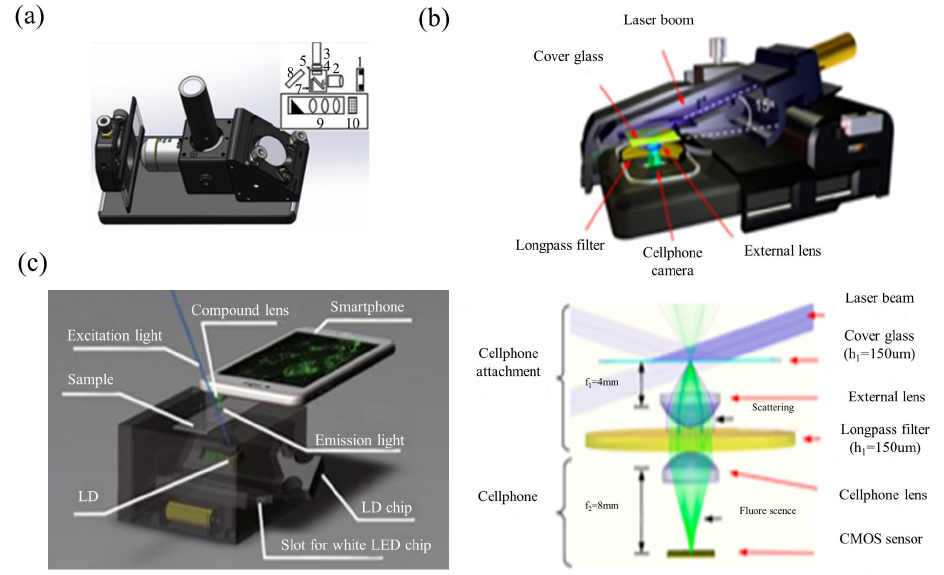
Figure 11. Smartphone-based fluorescent microscopy setups. ( a ) schematic illustration of the smartphone microscope [90]; ( b ) photograph and schematic of cell-phone-based fluorescence micro- scopes. [104]; and ( c ) schematic diagram of portable fluorescence microscopes [102].